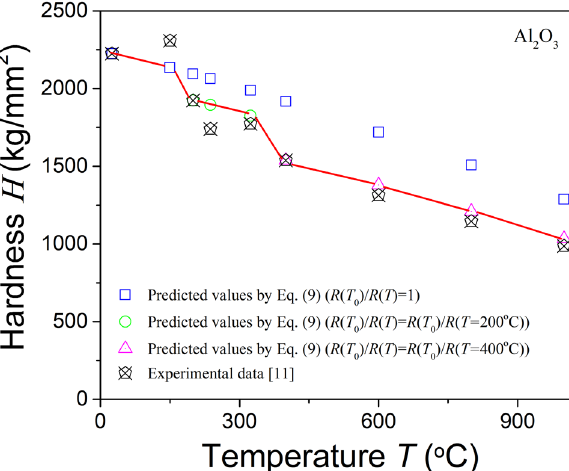
Figure 3: Comparison between the model - predicted and measured hardness of a SiC ceramic at high